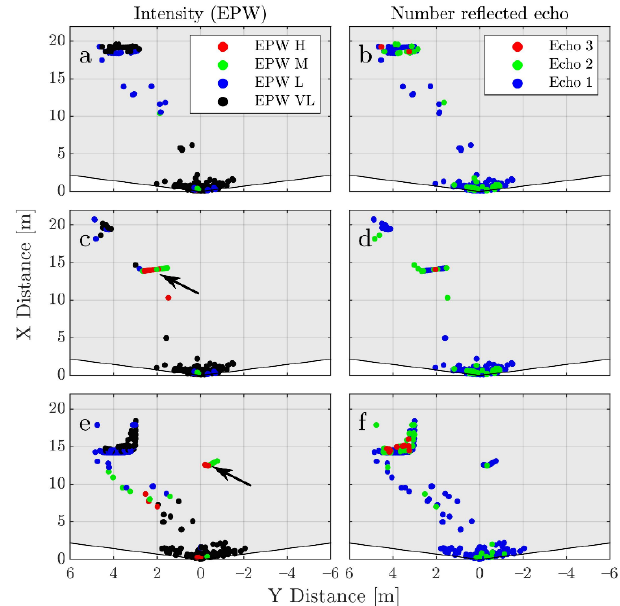
Figure 6. Examples of the generated synthetic frames. On the left side the detections are colored based on the EPW value and on the right are based on the echo number. In ( a , b ) there is no added obstacle. In ( c , d ) the effect of occlusion caused by the box is shown. In ( e , f ) a box that does not cause occlusion is added. The arrows in ( c , e ) show the position of the obstacle.